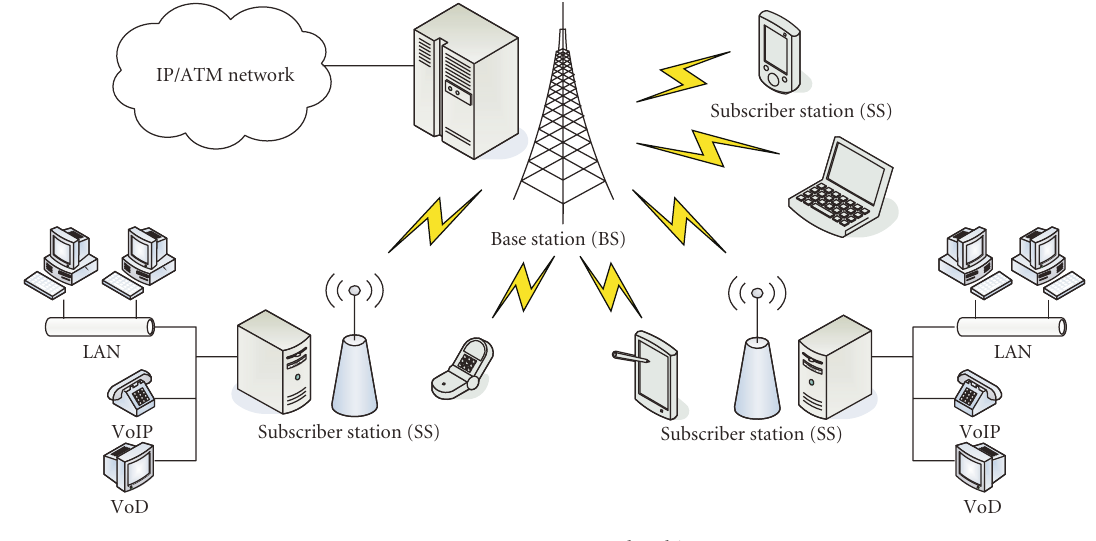
Figure 1: IEEE 802.16 general